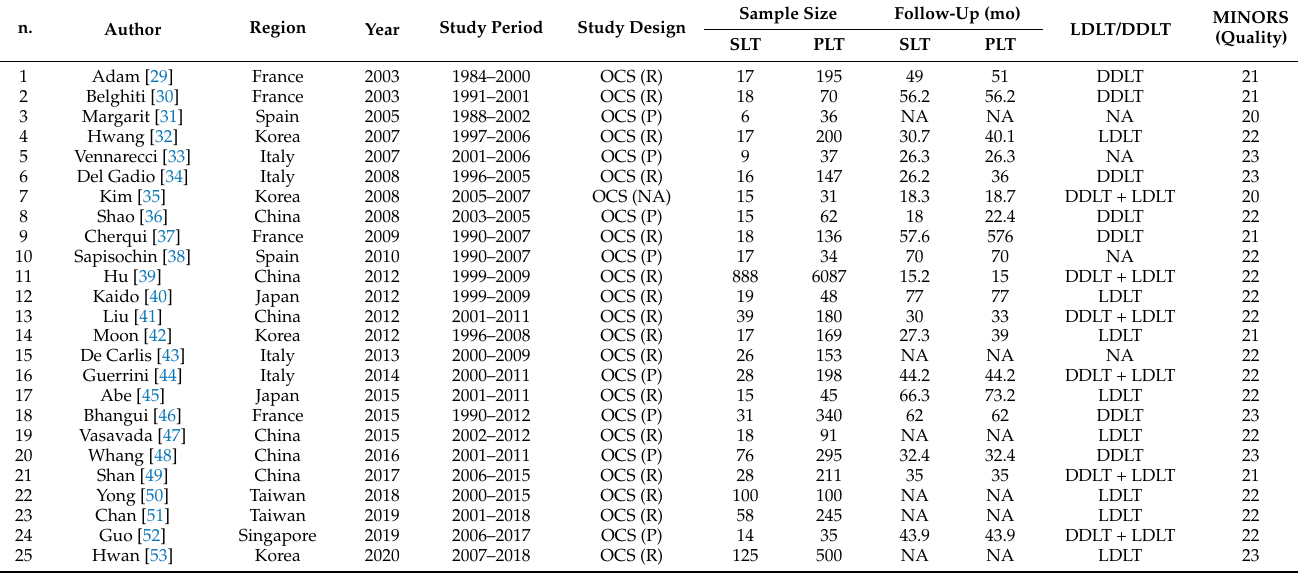
Table 1. Summary of studies included in the Meta-analysis.